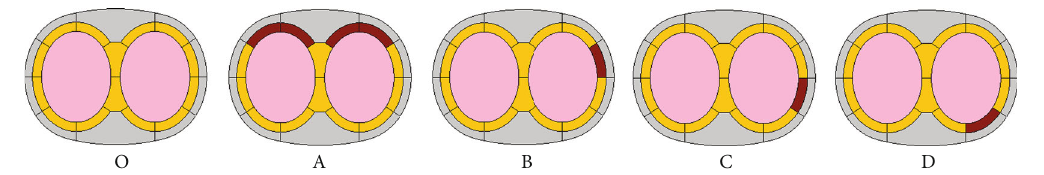
Figure 3: Cases of plague locations in the study.